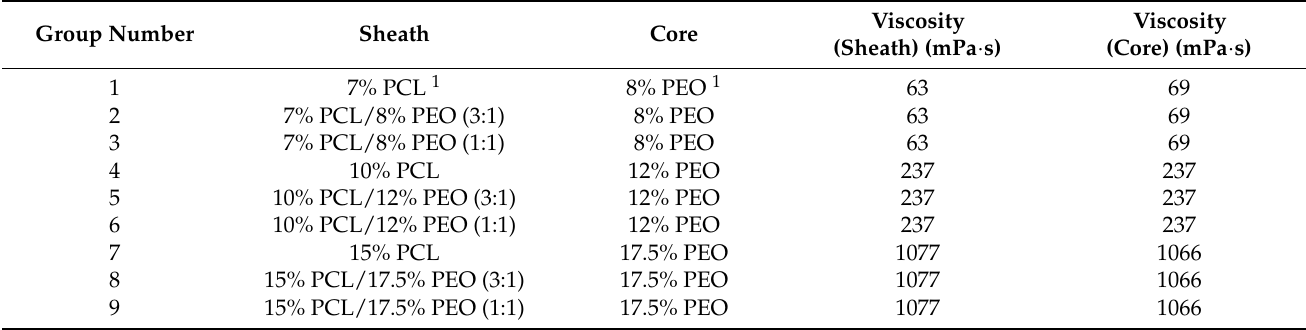
Table 1. Materials for the core-sheath electrospinning.